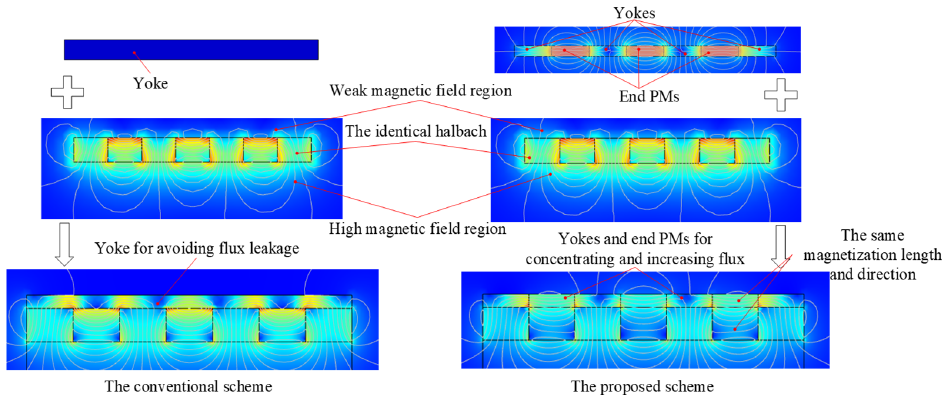
Figure 11. Comparison of design concepts of two